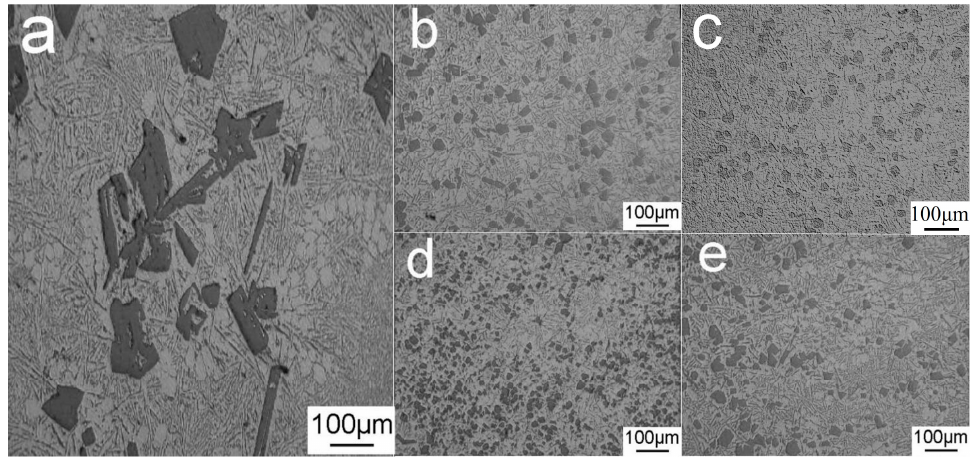
Figure 7. Metallographic diagram of Al–20Si alloy with different Al–20Si@Al 2 O 3 addition amounts: